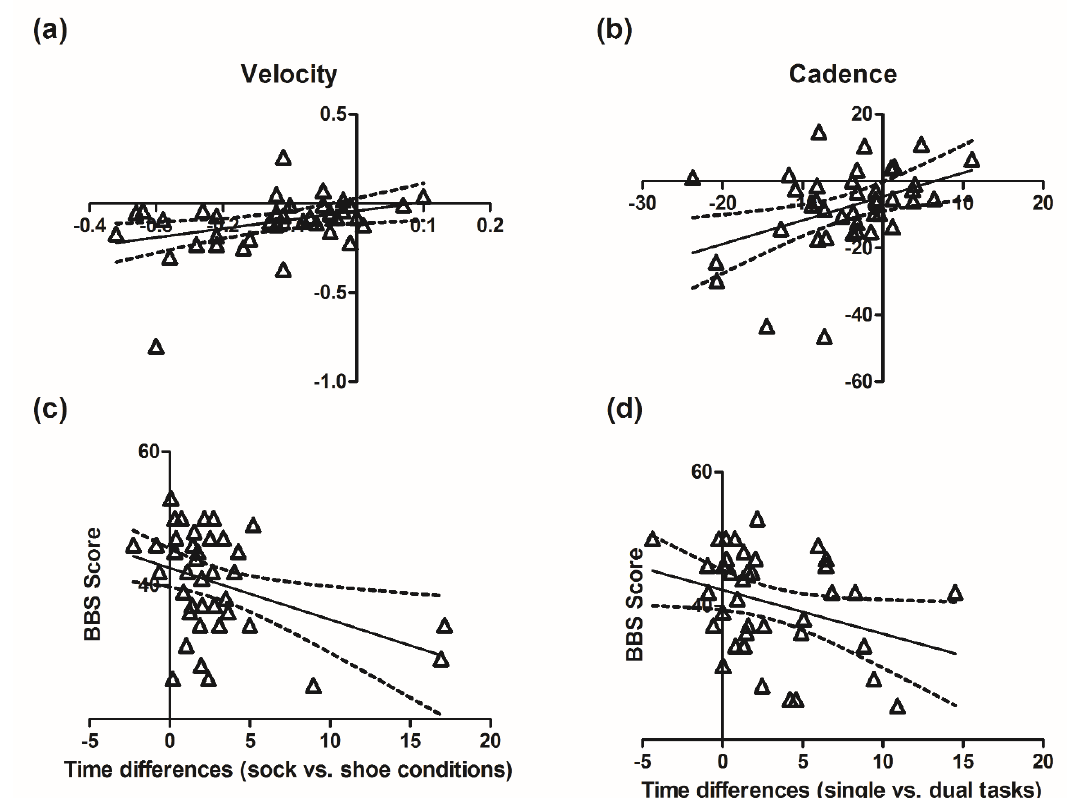
Figure 3. The correlations among kinematics and clinical assessments when the walking conditions changed for PwPMS. ( a , b ): x-axis: the difference between the shoes and the socks conditions (socks minus shoes); y-axis: the difference between the single task and DT conditions (single minus DT, both performed with shoes). Positive correlations were found in velocity (r = 0.3662, p = 0.0141) and cadence (r = 0.4158, p = 0.0076) between the differences of the shoes vs. socks condition and the single vs. DT conditions. ( c , d ): A significant negative correlation was found between the BBS scores and the time increases from shoe to sock conditions (r = − 0.3901, p = 0.0141), and a trend correlation was found with time increases of single versus dual tasks (r = − 0.3247, p = 0.0437).